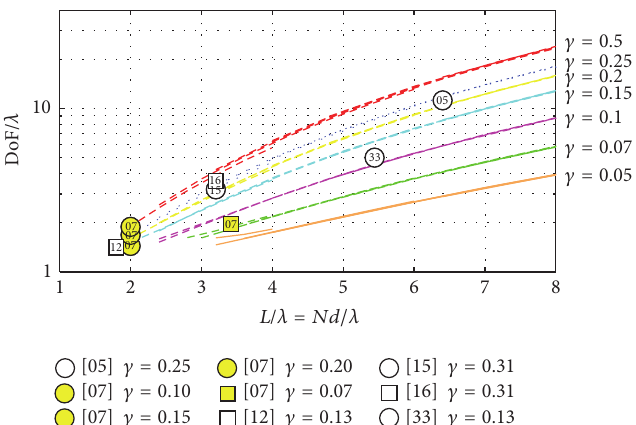
Figure 3: The depth of focus DoF as a function of the array size, 𝐿/𝜆 = 𝑁𝑑/𝜆 , for 0.05 < 𝛾 < 0.5 (see Figure 10 in [2]). The markers denote the performance of NFF arrays described in [5, 7, 12, 15, 16, 33]; the circles and squares are related to simulated and measured results, respectively; for each referenced paper, the empty markers indicate results given by the authors and the filled markers are results extracted from figures. 𝛾 is the focal distance 𝑅 𝐹 normalized to the radius of the far-field region boundary ( 2𝐿 2 /𝜆 ).